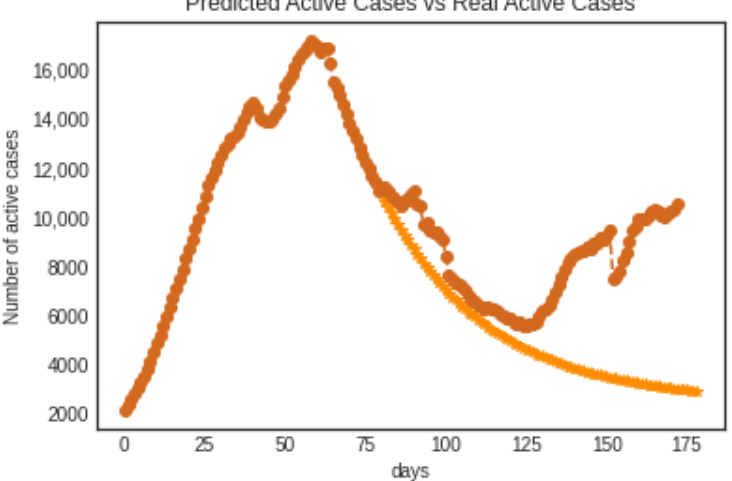
Figure 6. Predicted infected cases (active) vs. real active cases based on the time-dependent SIR model. X ( t ) is the dark orange, and ¯ X ( t ) is the light